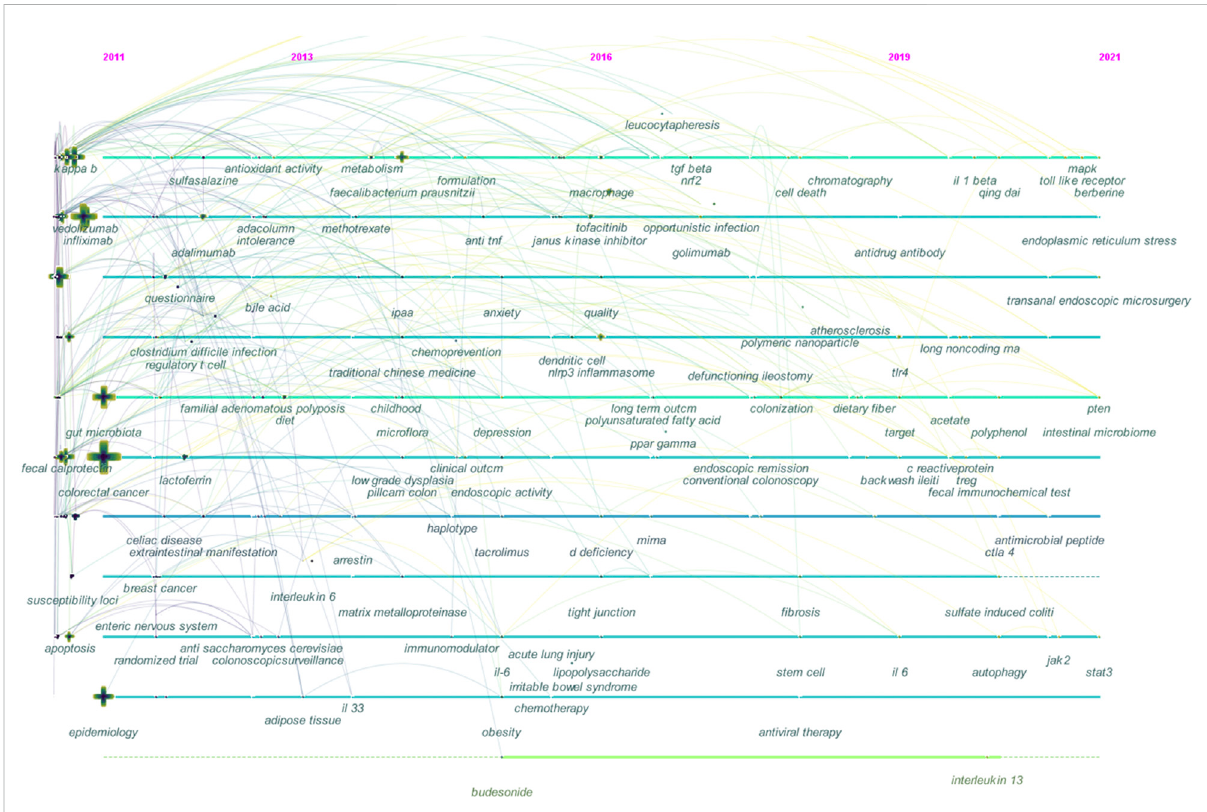
FIGURE 6 Timeline view of co-occurring keywords in UC research. Note: Each node represents a keyword, and the colors represent the node ’ s average year of publication. Each cross represents a citation burst of a keyword co-occurrence. Time zones are represented chronologically by vertical lines spread from left to right in the timeline view. In the leftmost position are the earliest nodes, whereas the rightmost positions are the most recent. In this view, the horizontal arrangement of nodes is restricted to the time zones they occupy, but the nodes are permitted to have vertical connections with nodes in other time zones. The vertical connections between nodes indicate the co-occurrence of keywords from different